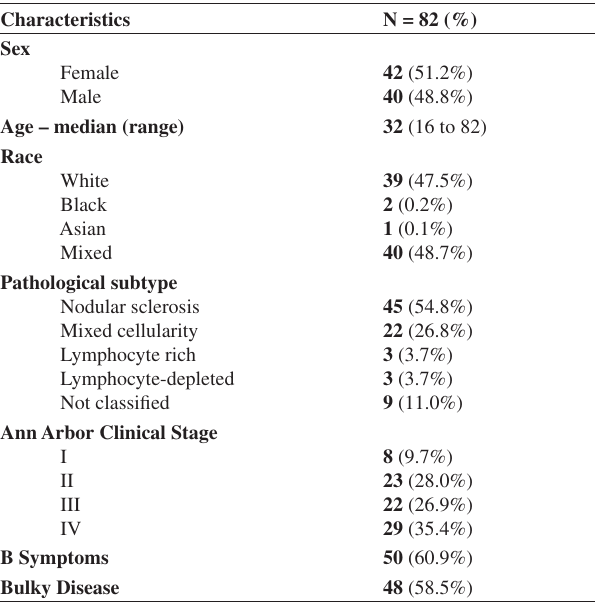
Table 1 - Demographic and clinical characteristics of the Hodgkin’s lymphoma